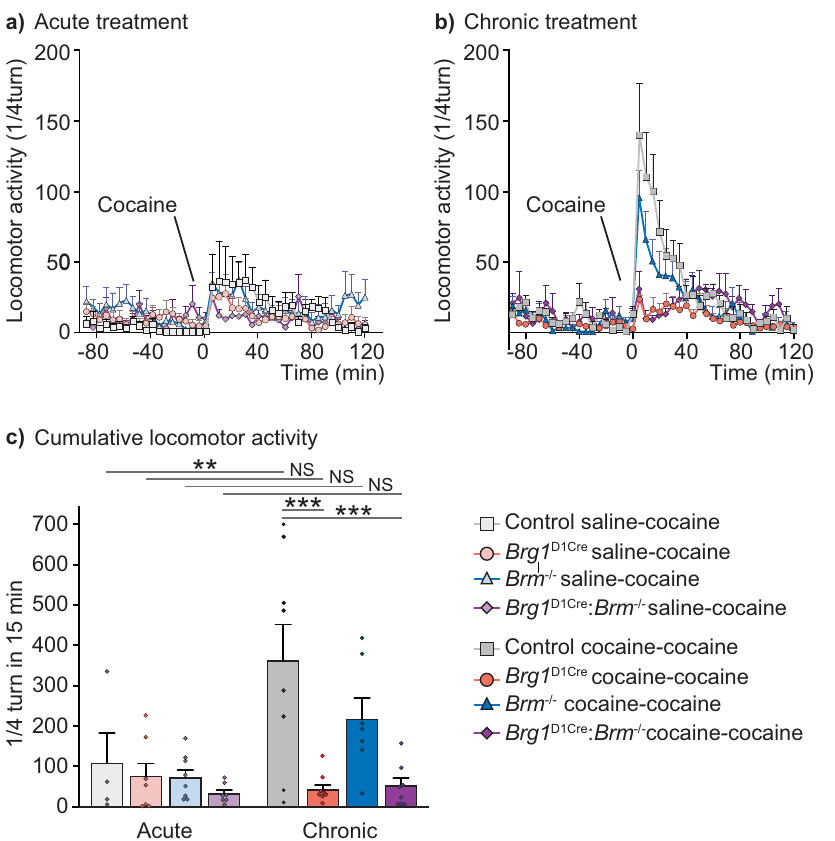
Fig. 3 Behavioral sensitization to cocaine in control, Brg1 D1Cre , Brm -/- and Brg1 D1Cre : Brm -/- mice. a Locomotor response (by 5 min blocks) to a cocaine injection (10 mg/kg) in saline pre-treated controls (n = 4), Brg1 D1Cre (n = 7), Brm -/- (n = 8) and Brg1 D1Cre : Brm -/- (n = 7) mice. b Locomotor response (by 5 min blocks) to a cocaine injection (10 mg/kg) in cocaine pre-treated control ( n = 8), Brg1 D1Cre ( n = 8), Brm -/- ( n = 7) and Brg1 D1Cre : Brm -/- ( n = 8) mice. c Locomotor sensitization (cumulated activity during 15 min after injection) to cocaine in control (acute n = 4; chronic n = 8), Brg1 D1Cre (acute n = 7; chronic n = 8), Brm -/- (acute n = 8; chronic n = 7), and Brg1 D1Cre : Brm -/- (acute n = 7; chronic n = 8) mice. Main drug effect F(1,49) = 8.19; p = 0.0062. Interaction genotype x drug F(3,49) = 3.43; p = 0.0241. Two-way ANOVA followed by Bonferroni correction acute vs chronic ** p = 0.0059, NS = not signi fi cant ( p > 0.99 for Brg1 D1Cre and Brg1 D1Cre : Brm -/- , p = 0.123 for Brm -/- ); control vs Brg1 D1Cre ***p < 0.0001; control vs Brg1 D1Cre : Brm -/- *** p < 0.0001. Data are represented as mean ± s.e.m. Data are provided in a Source Data fi